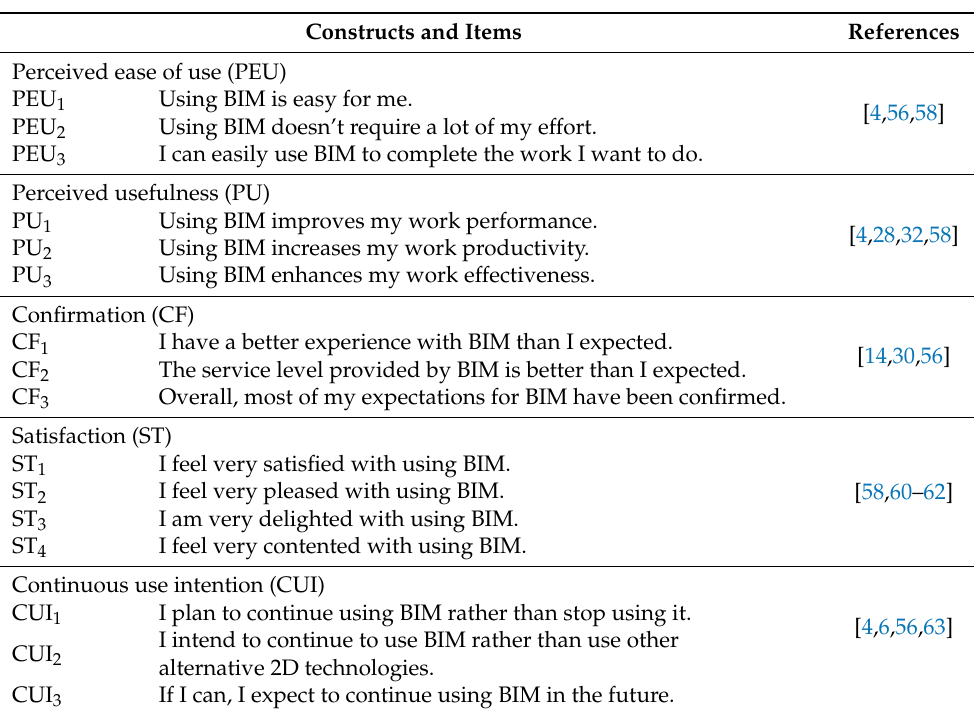
Table 1. Constructs, items, and